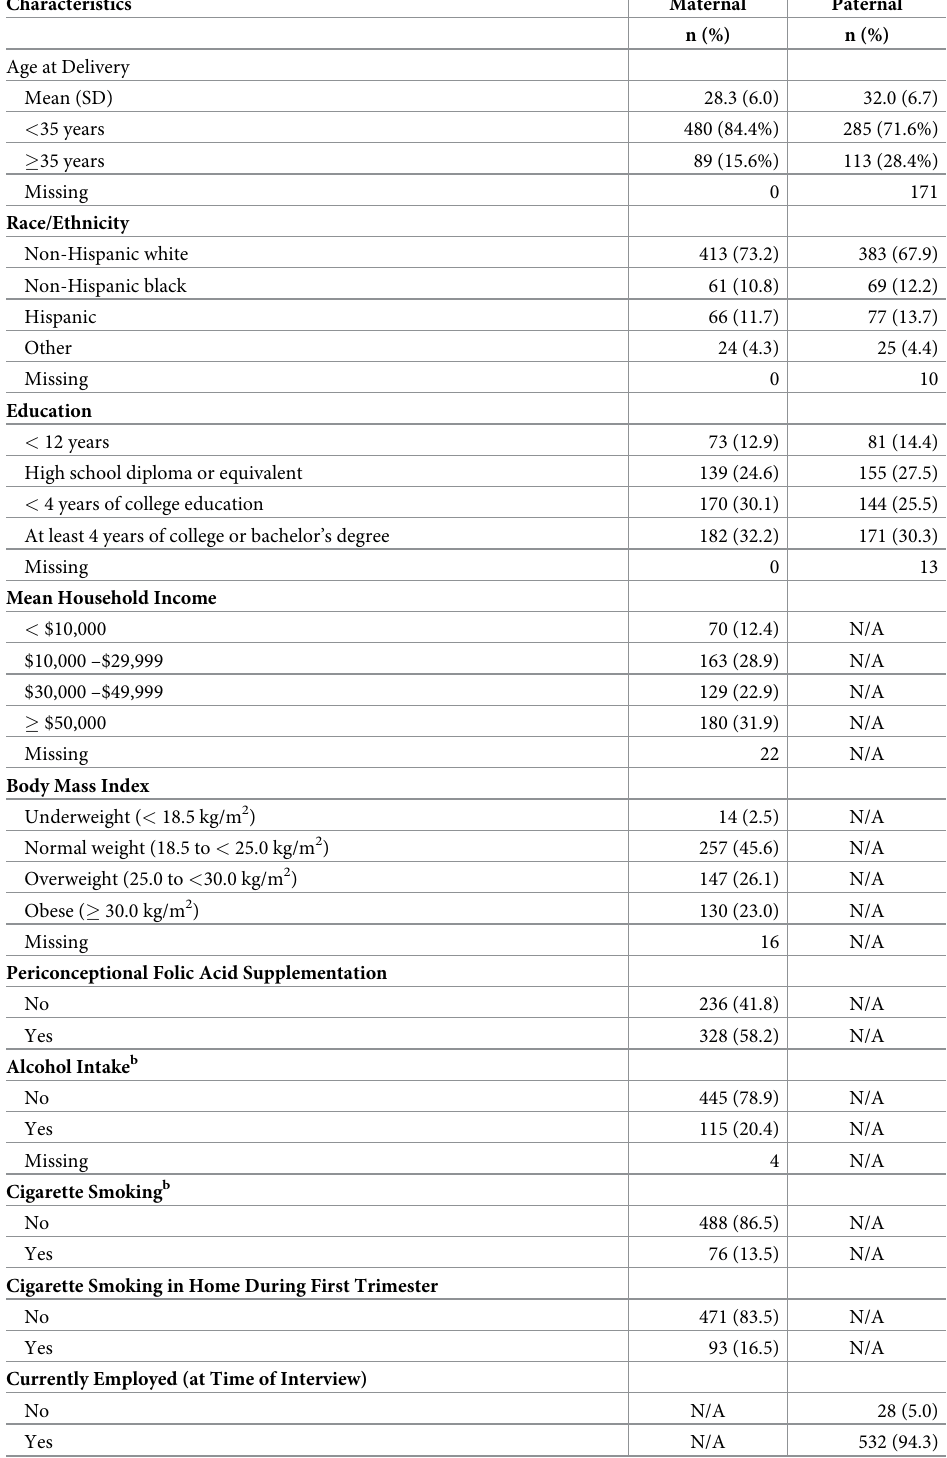
Table 1. Summary of maternal and paternal characteristics from chi-squared analyses for mothers of infants with obstructive heart defects, The National Birth Defects Prevention Study, USA, October 1997 –August 2008 births (n = 569 case families) a